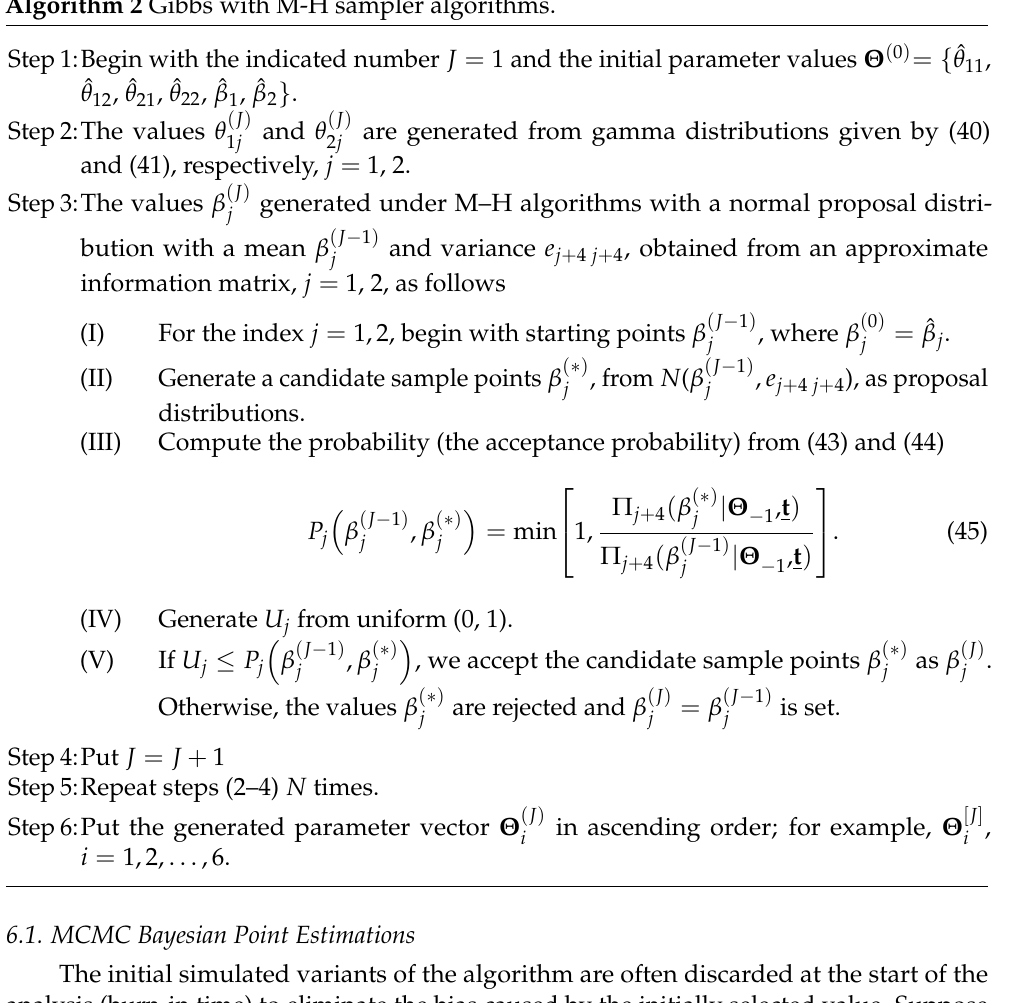
Algorithm 2 Gibbs with M-H sampler